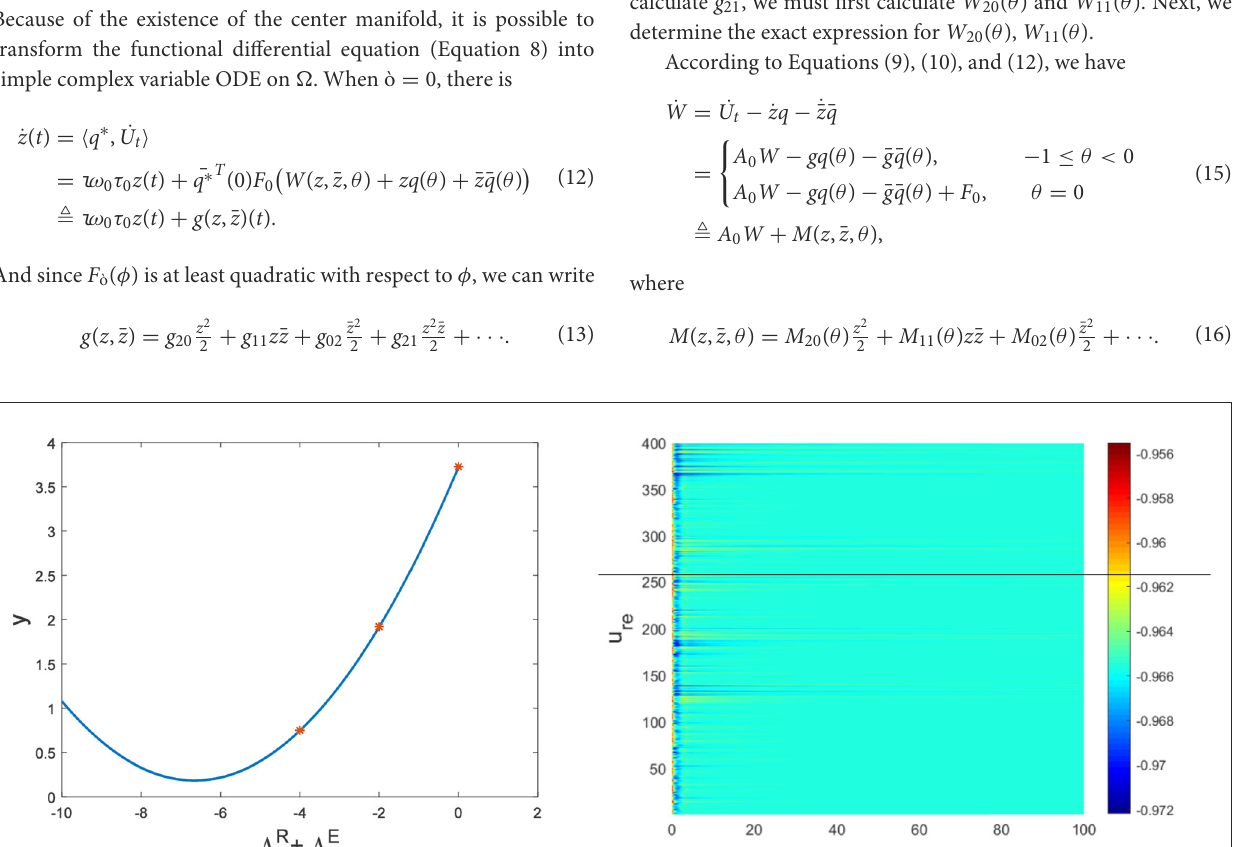
FIGURE3 The relationship between 3 R α red dots are the eigenvalues of the network Laplacian matrix.